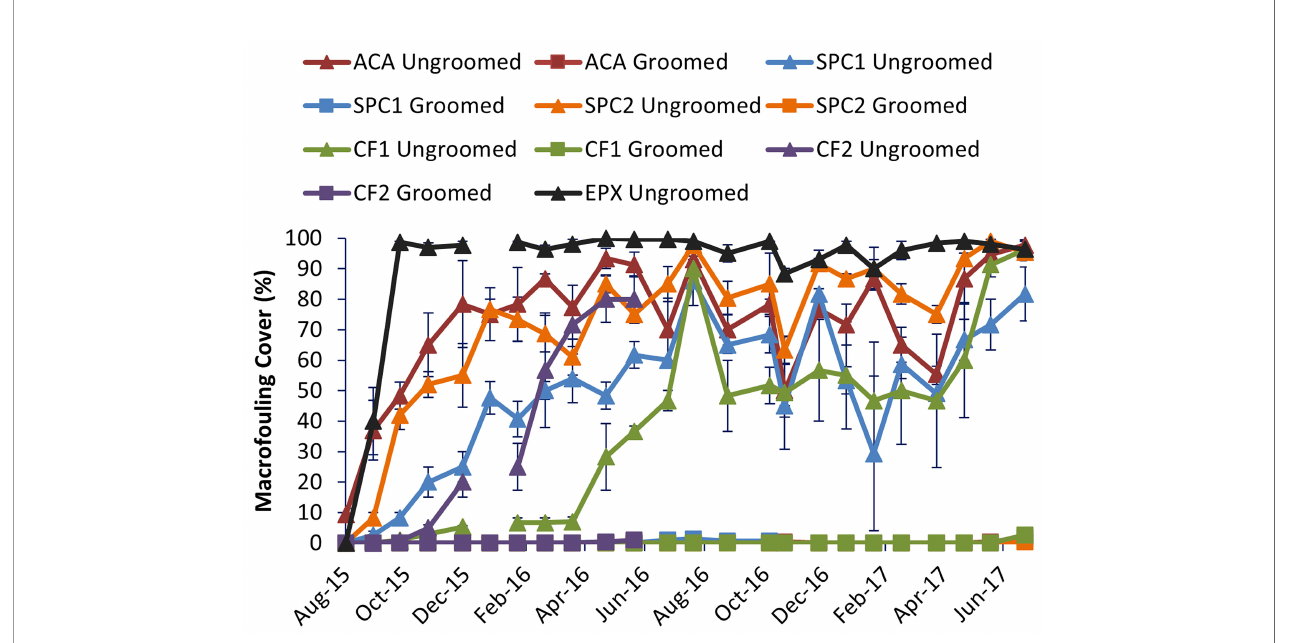
FIGURE 1 | Comparison of macrofouling cover among the different coatings. Error bars represent one standard error, n=3 replicate panels for each coating and grooming condition.